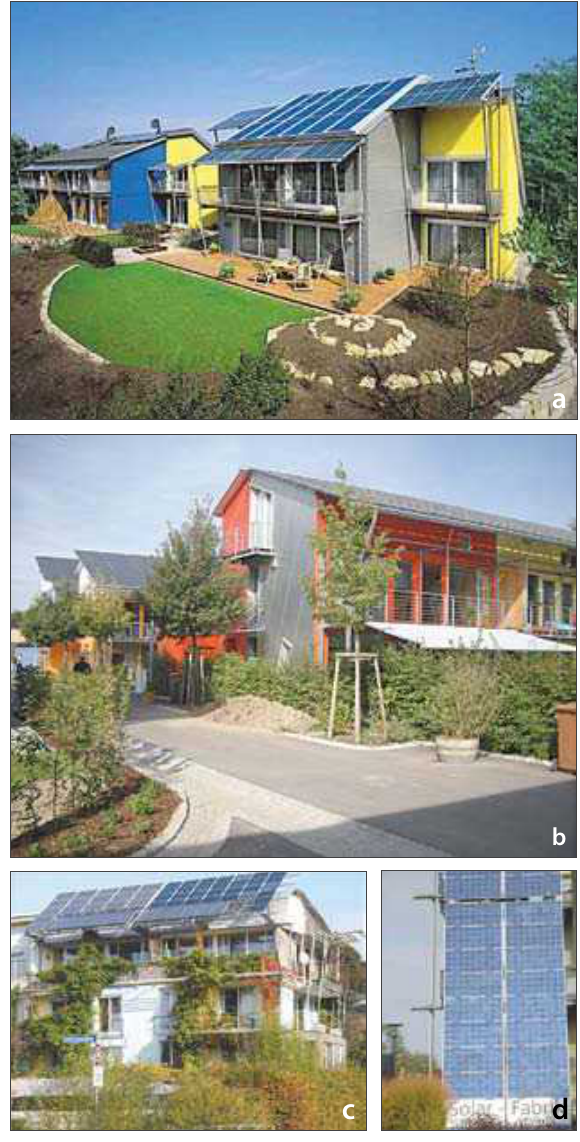
Fig. 5. architecture of new buildings with sun-power collectors (a, b, c,